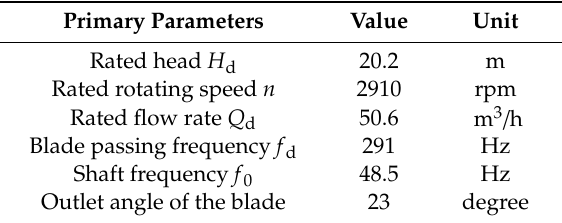
Table 1. Primary parameters of the centrifugal pump.